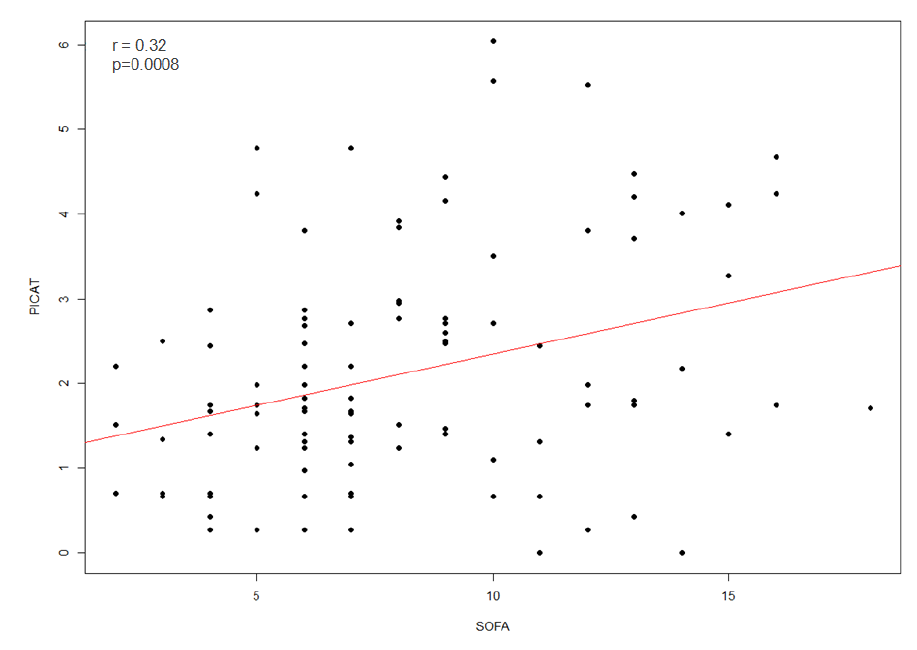
Figure 2. Correlation (red line) between PICAT score and SOFA score ( n = 109) at time of admission in ICU with r = 0.32 and p =0.0008.